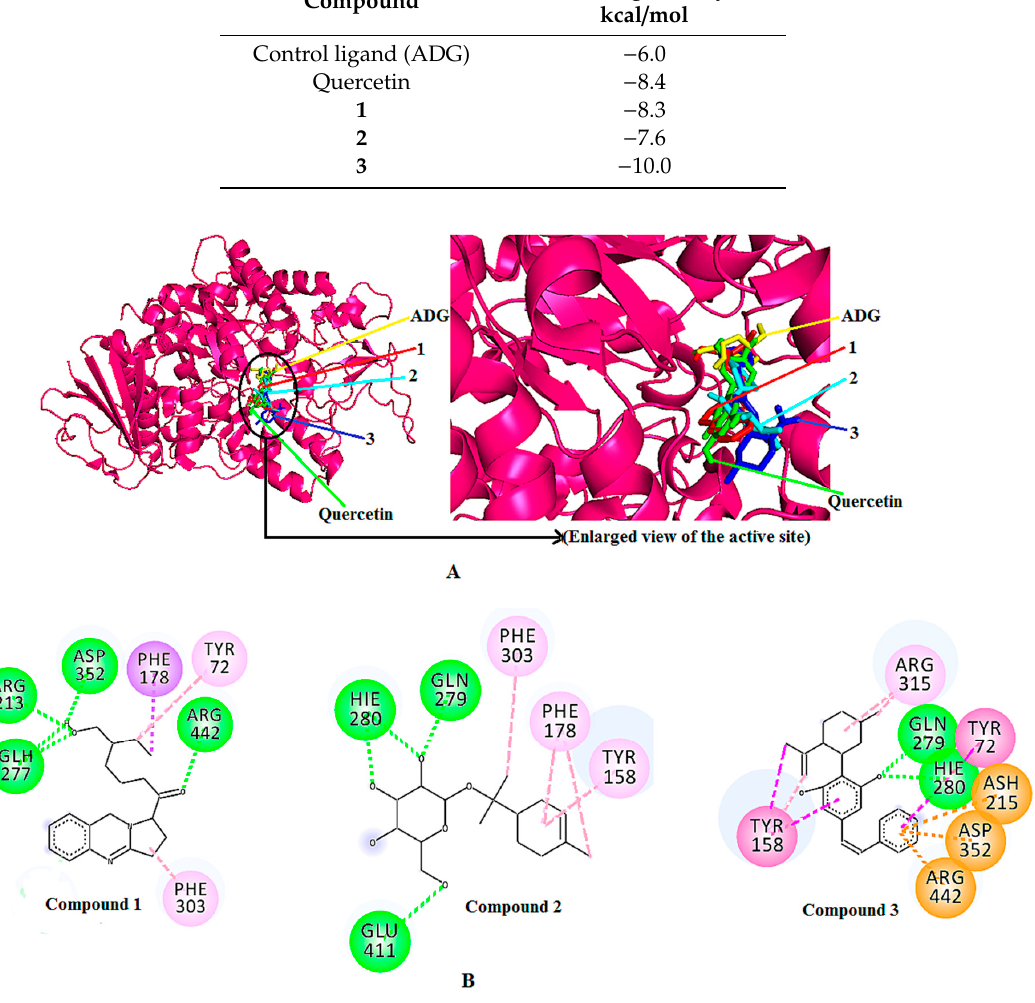
Figure 5. ( A ) Superimposed 3D diagram of control ligand (ADG), positive control (quercetin), the docked compounds 1 , 2 , and 3 . ( B ) 2D binding interactions of the docked compound 1 , 2, and 3 with α -glucosidase